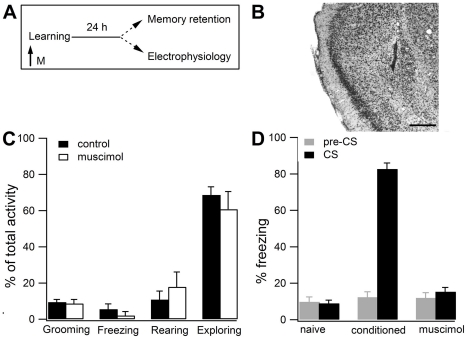
Effects of pretraining BLA inactivation on spontaneous and conditioned fear behavior.
A. Experimental design. The arrow indicates pretraining muscimol (M) injection. B. Photomicrograph (magnification 4X) showing the position of the needle track in animals that received muscimol into BLA. Scale bars, 300 µm. C. Spontaneous activities showed by control (filled columns) and muscimol-injected (empty columns) animals before shock presentation. D. Long-term memory retention evaluated 24 h after conditioning by measuring freezing 2 min before (gray columns) and during CS presentation (filled columns). All values are mean ± SEM.